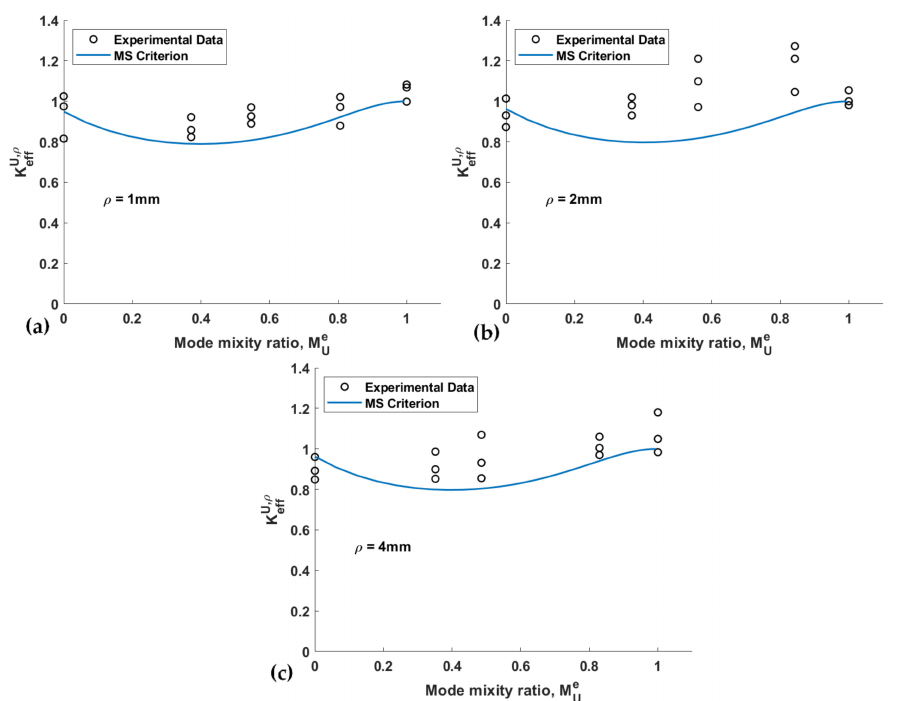
Figure 11. Effective normalized fracture resistance predictions vs. mode mixity ratio when using the MS criterion and corresponding experimental data. ( a ) ρ = 1 mm; ( b ) ρ = 2 mm; ( c ) ρ = 4